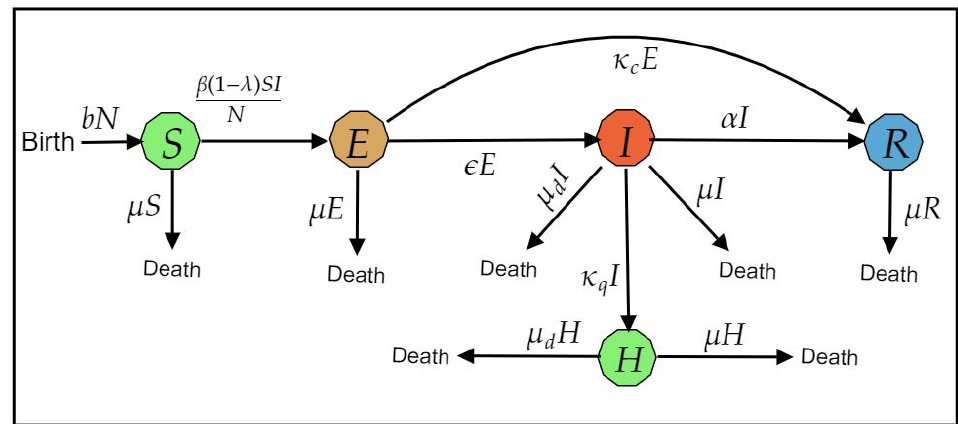
Figure 1. Transmission diagram of COVID-19